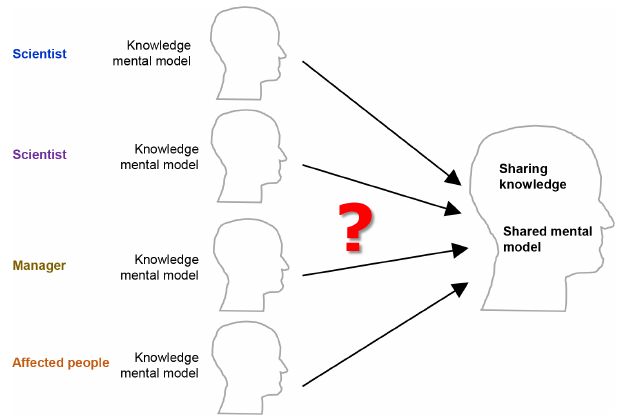
Figure 2. Sharing knowledge through shared mental